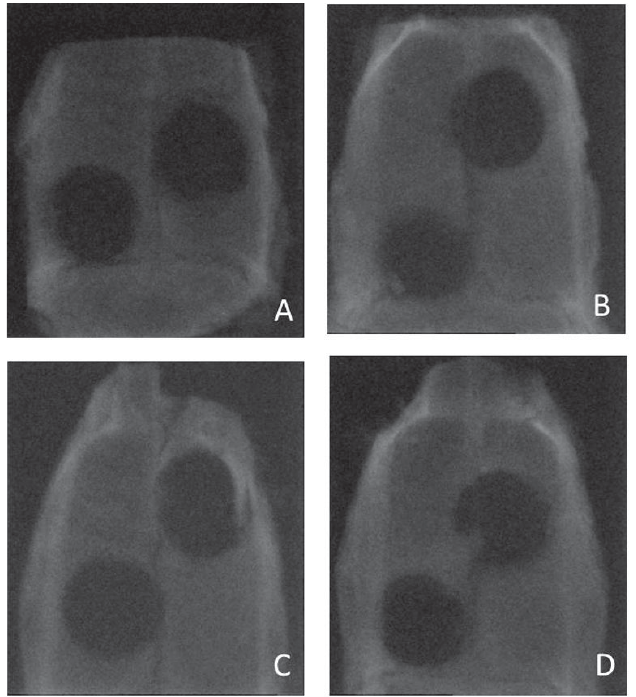
Fig. 1. Radiographs showing calvarial defects in each treatment group. A- ACS (left defect), Saline (right defect) 4 weeks; B- ACS (left defect), Saline (right defect) 8 weeks; C- HA+ACS (left defect), HA (right defect) 4 weeks; D- HA+ACS (left defect), HA (right defect) 8